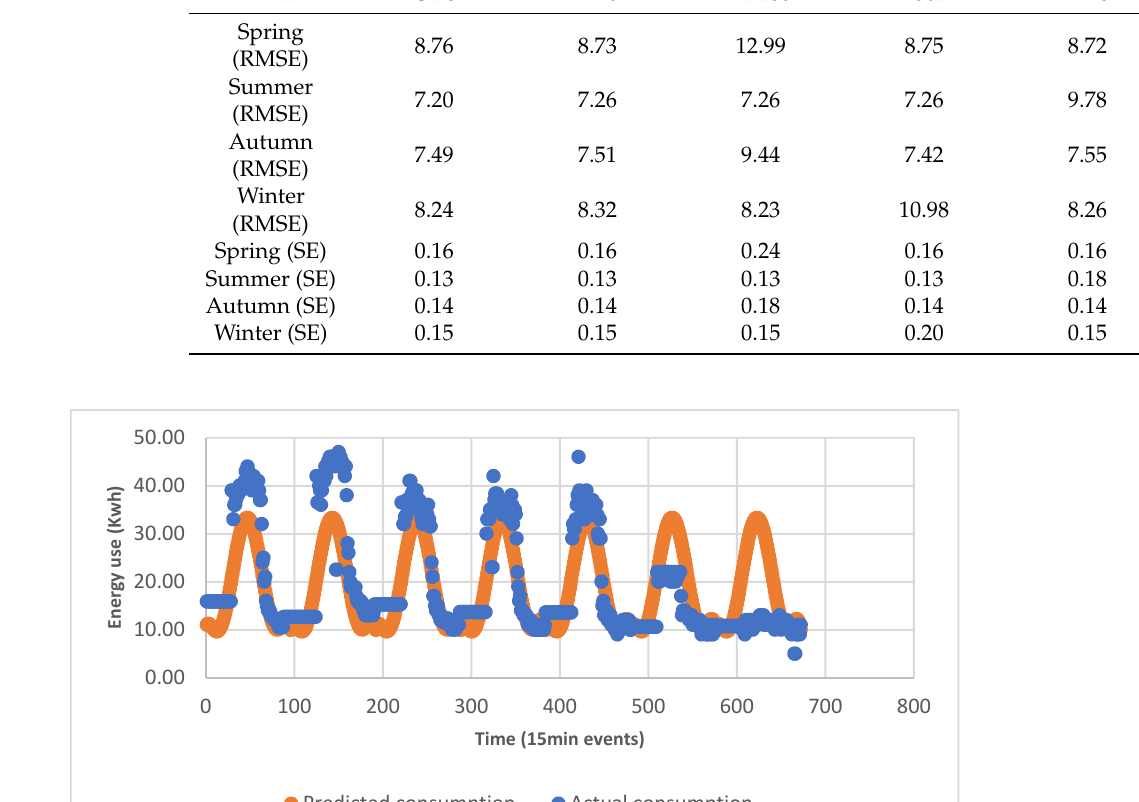
Figure A6. A comparison of weekday and weekend segmented weekly PR prediction, to actual con- sumption and the unsegmented predicted consumption, in the first week of autumn.